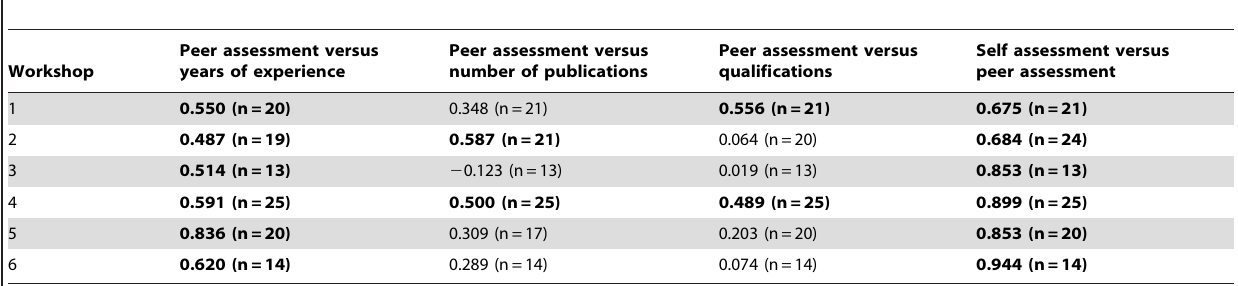
Table 2. Pearson correlations between peer assessments of expert performance and measures of expertise, and between self- assessed expertise and peer assessments of expertise.